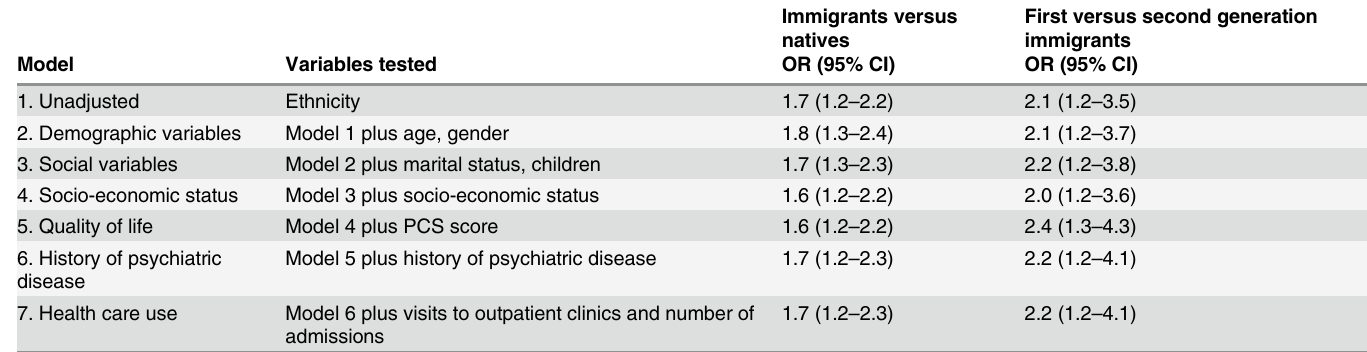
Table 3. Odds ratios for presence of psychological distress for immigrant patients versus native patients and first generation immigrant patients versus second generation immigrant